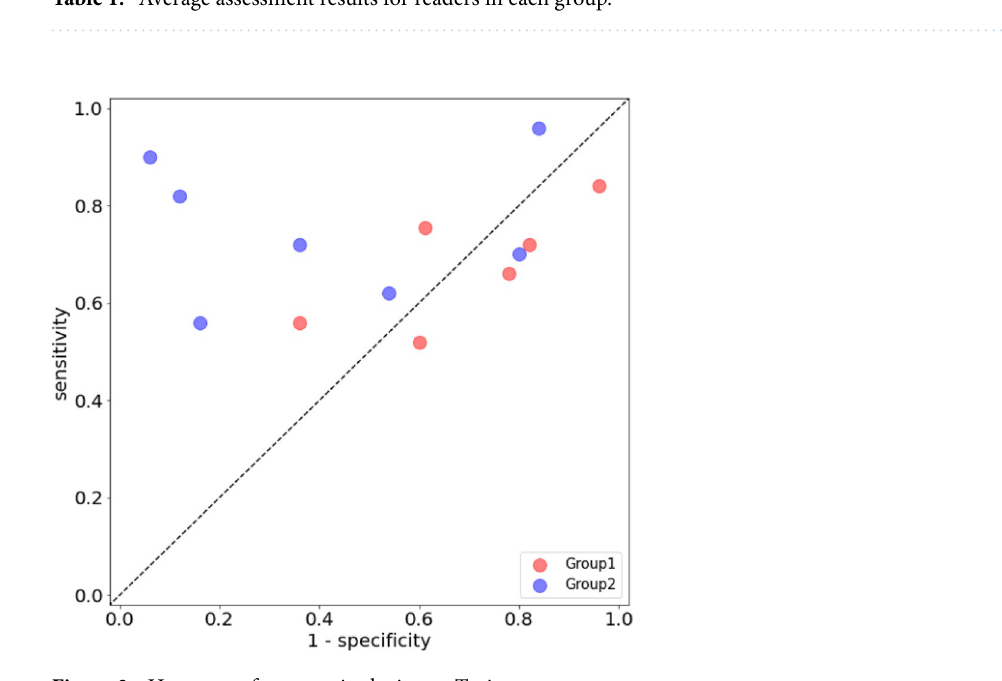
Figure 3. Human performance in the image Turing